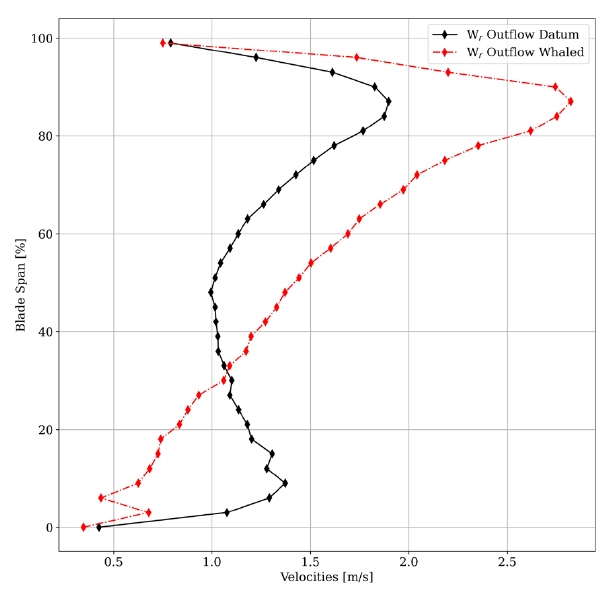
Figure 8. Radial velocity at the outlet of the datum fan (black) and the whale fan (red).